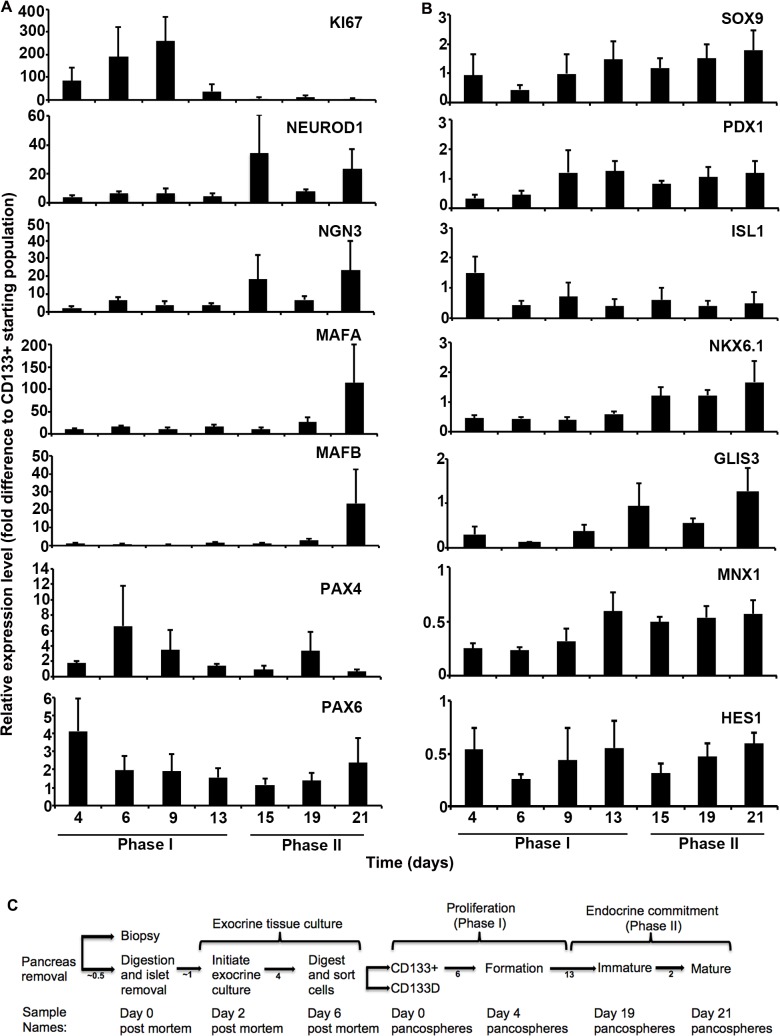
Relative mRNA expression level of endocrine development transcription factors by differentiating pancospheres (PS) over time.Mean ± SEM (n = 3 exocrine cultures) relative expression level reported as fold difference from CD133+ starting population shown on Y-axis. Days after initiating PS formation shown along X-axis. Proliferative (Phase I) and maturation (Phase II) phases shown at bottom. A, Upregulated genes are: marker of proliferation Ki-67 (KI67), Neuronal differentiation 1 (NEUROD1), Neurogenin 3 (NGN3), v-maf avian musculoaponeurotic fibrosarcoma oncogene homolog A (MAFA), v-maf avian musculoaponeurotic fibrosarcoma oncogene family, protein B (MAFB), paired box 4 (PAX4), paired box 6 (PAX6). B, Down regulated genes are: SRY (sex determining region Y)-box 9 (SOX9), pancreatic and duodenal homeobox 1 (PDX1), ISL LIM homeobox 1 (ISL1), NK6 homeobox 1 (NKX6.1), GLIS family zinc finger 3 (GLIS3), motor neuron and pancreas homeobox 1 (MNX1), Hairy enhancer of split 1 (HES1). C, Isolation and endocrine differentiation of NGN3+ cells. After death, pancreas is removed and transported to an islet isolation facility where a biopsy is taken for histology. The pancreas is then digested and separated into islets and exocrine tissue. Exocrine culture is initiated on day 2 post mortem. On day 6 post mortem, tissue is digested to single cells, which are labeled and sorted for expression of CD133. CD133+ cells are plated on pancosphere day 0. Samples are collected on pancosphere days 4, 6, 9, 13, 15, 19 and 21. Cell proliferation marker KI67 expression peaks at pancosphere day 9. On pancosphere day 19 IGF II is withdrawn and cells begin final maturation. Days between each step are indicated below arrows. Exocrine tissue culture and phases of pancosphere differentiation are shown above the timeline.